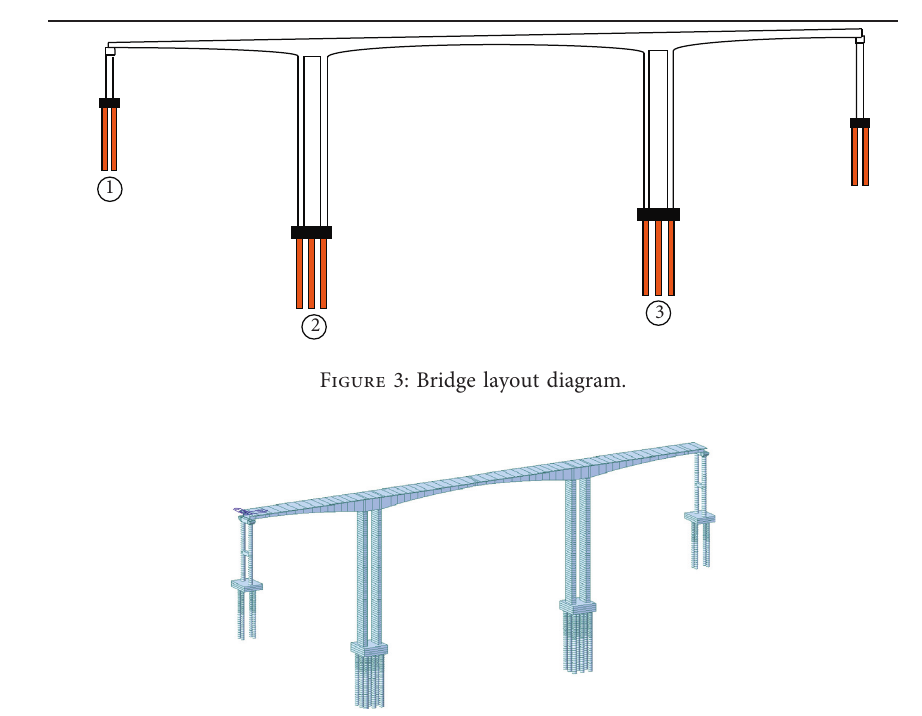
Figure 4: Dynamic finite element model of the bridge. Table 2: Deterioration parameters of steel corrosion.